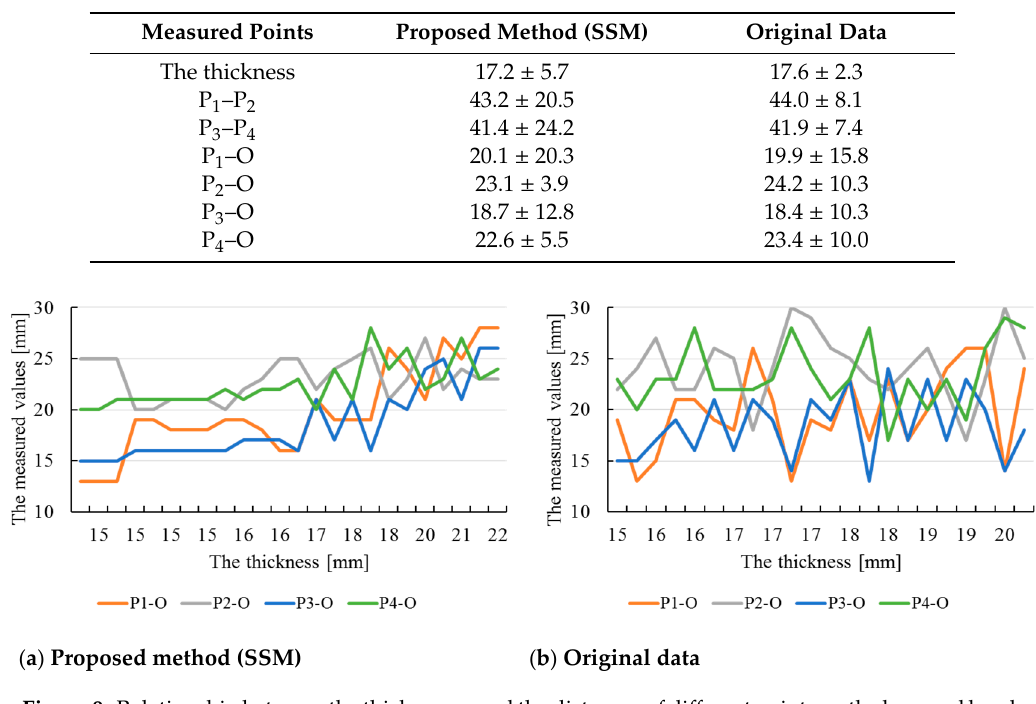
Figure 9. Relationship between the thicknesses and the distances of different points on the humeral head. Table 2. The correlation coefficient between thickness and each measured values of different points on the humeral head.